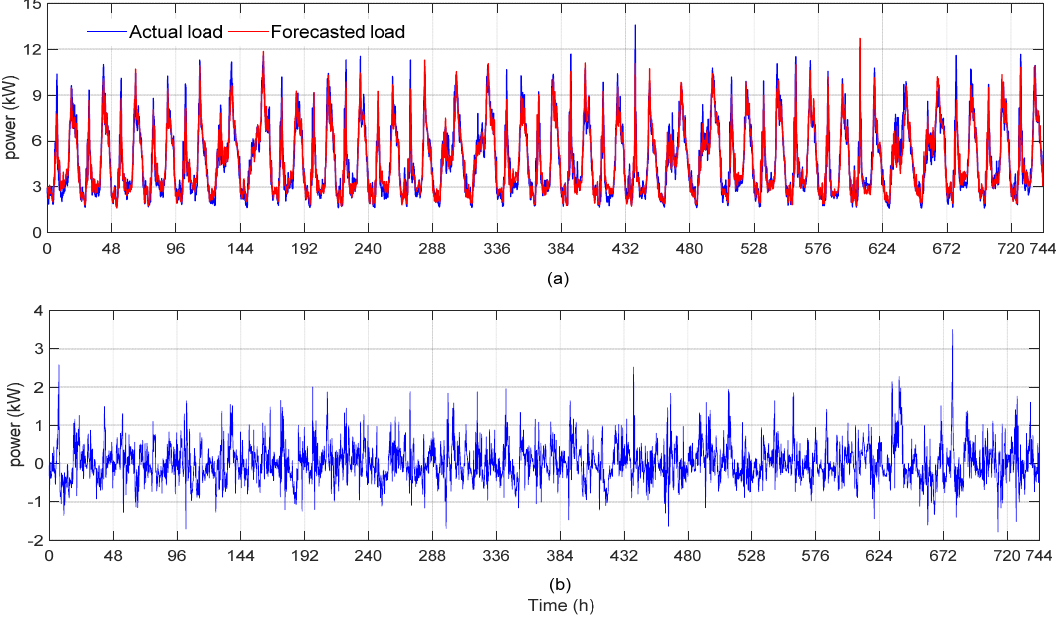
Figure 4. ( a ) The actual and the forecasted load demand for one month; ( b ) the difference between the actual and the forecasted load demand.